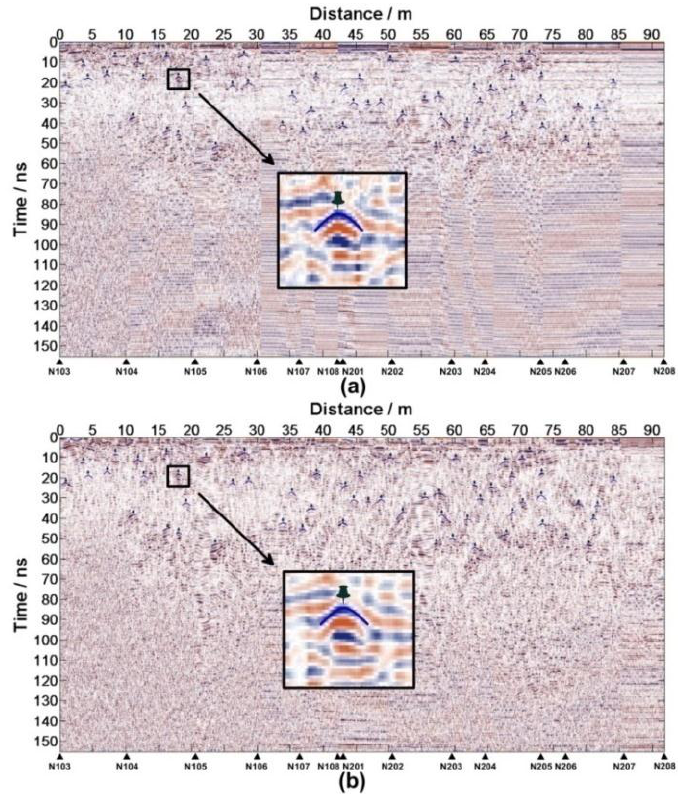
Figure 13. ( a ) Reflected waves caused by basalt blocksshown in CH-2A data and ( b ) Reflected waves caused by basalt blocksshown in CH-2B data. Sensors 2018 , 18 , x